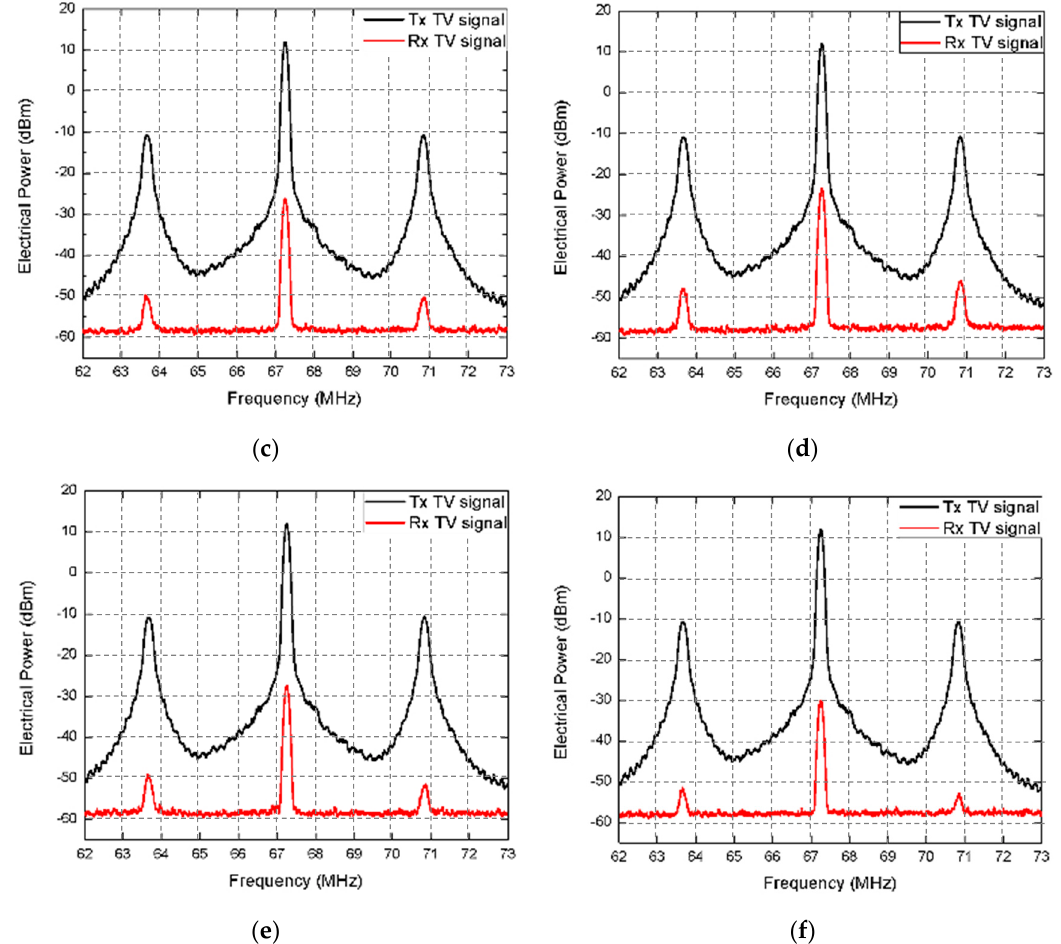
Figure 5. Electrical spectrum for the transmitted and recovered analog TV-signal for each ml. ( a ) ml 1 : SNR RX = 30.99 dB; ( b ) ml 2 : SNR RX = 26.04 dB; ( c ) ml 3 : SNR RX = 33.67 dB; ( d ) ml 4 : SNR RX = 36.53 dB; ( e ) ml 5 : SNR RX = 32.59 dB; and ( f ) ml 6 : SNR RX = 29.82 dB.